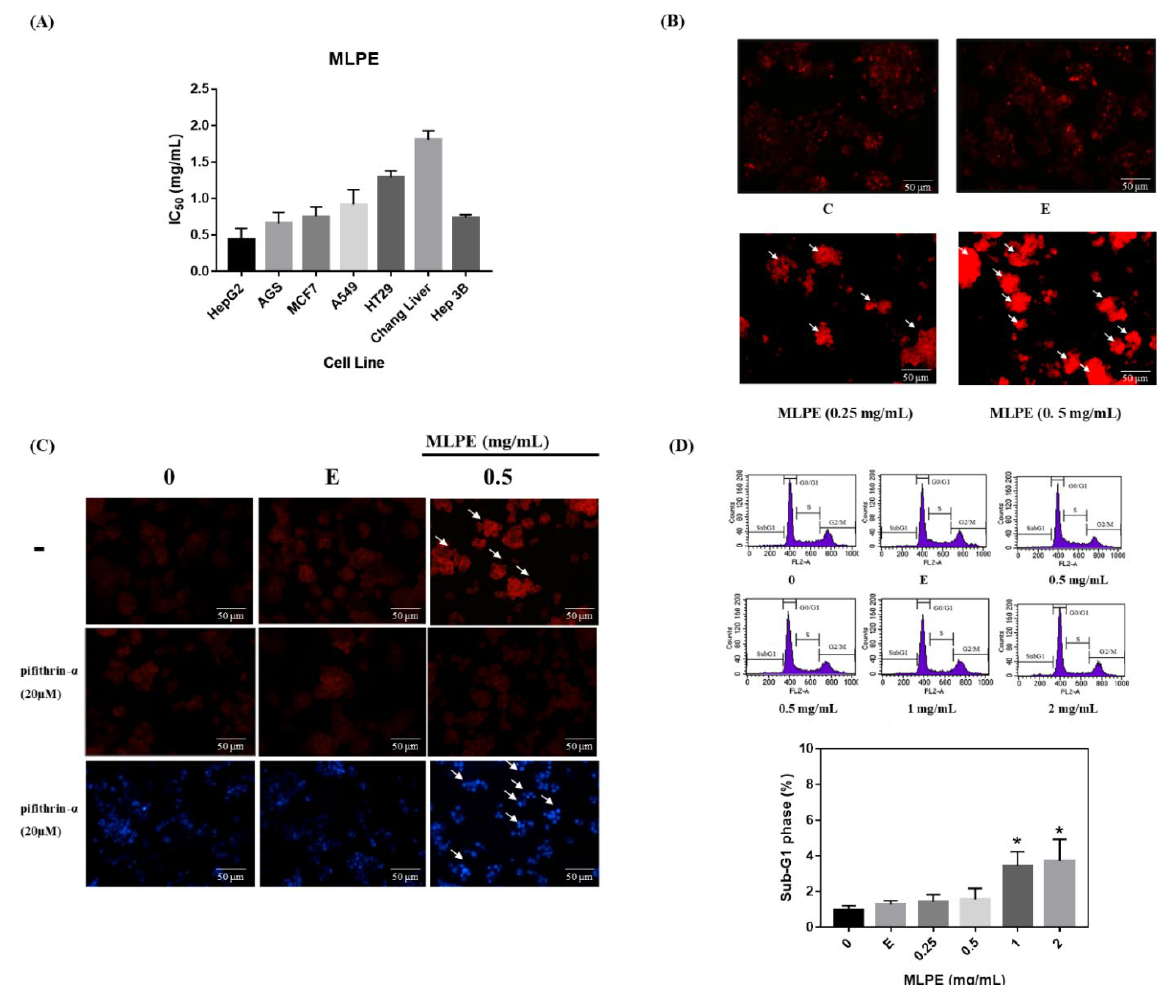
Figure 2. Autophagy-dependent p53 effects of MLPE on HepG2 cells. ( A ) IC50 of MLPE on the viability in different cell lines. ( B ) HepG2 cells were treated with 0, 0.25, 0.5 mg/mL of MLPE and solvent for 24 h and subjected to AVO staining. The arrow indicated AVO cells. AVOs values were calculated as the percentage of AVO cells relative to the total number of cells in each random field. Results were statistically analyzed with Student’s t-test. Magnification: 400 × . ( C ) HepG2 cells were pretreated with PFT α for 6 h and treated with 0, 0.5 mg/mL of MLPE and solvent for 24 h and subjected to DAPI/AO